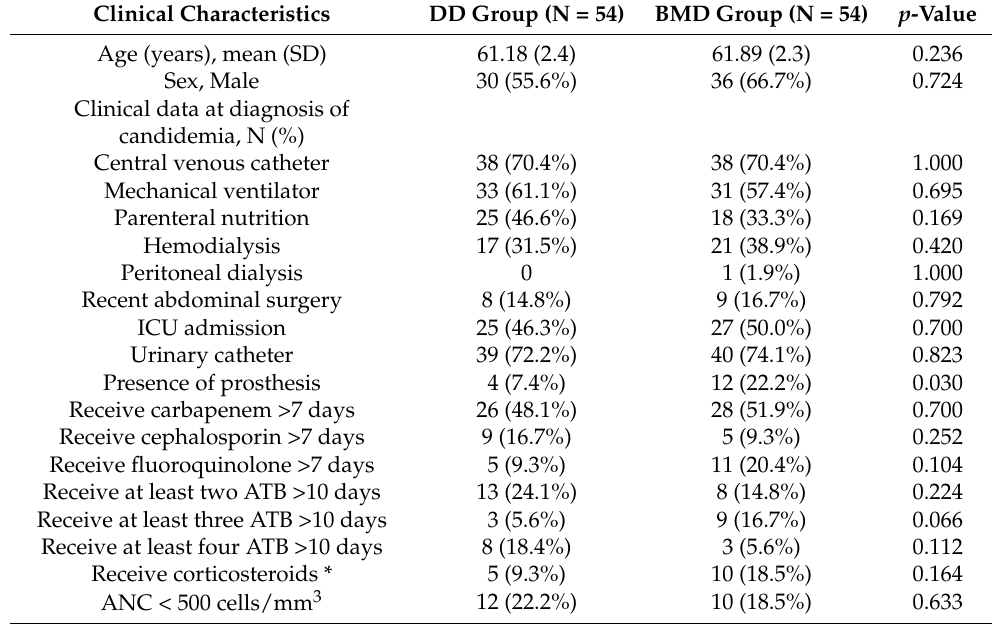
Table 1. Clinical characteristics of patients enrolled in the